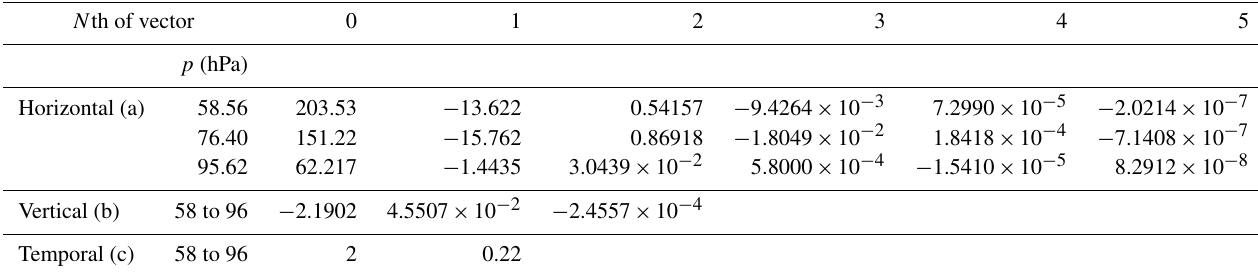
Table 1. Parameterization of the O 3 / PV ratio correlation